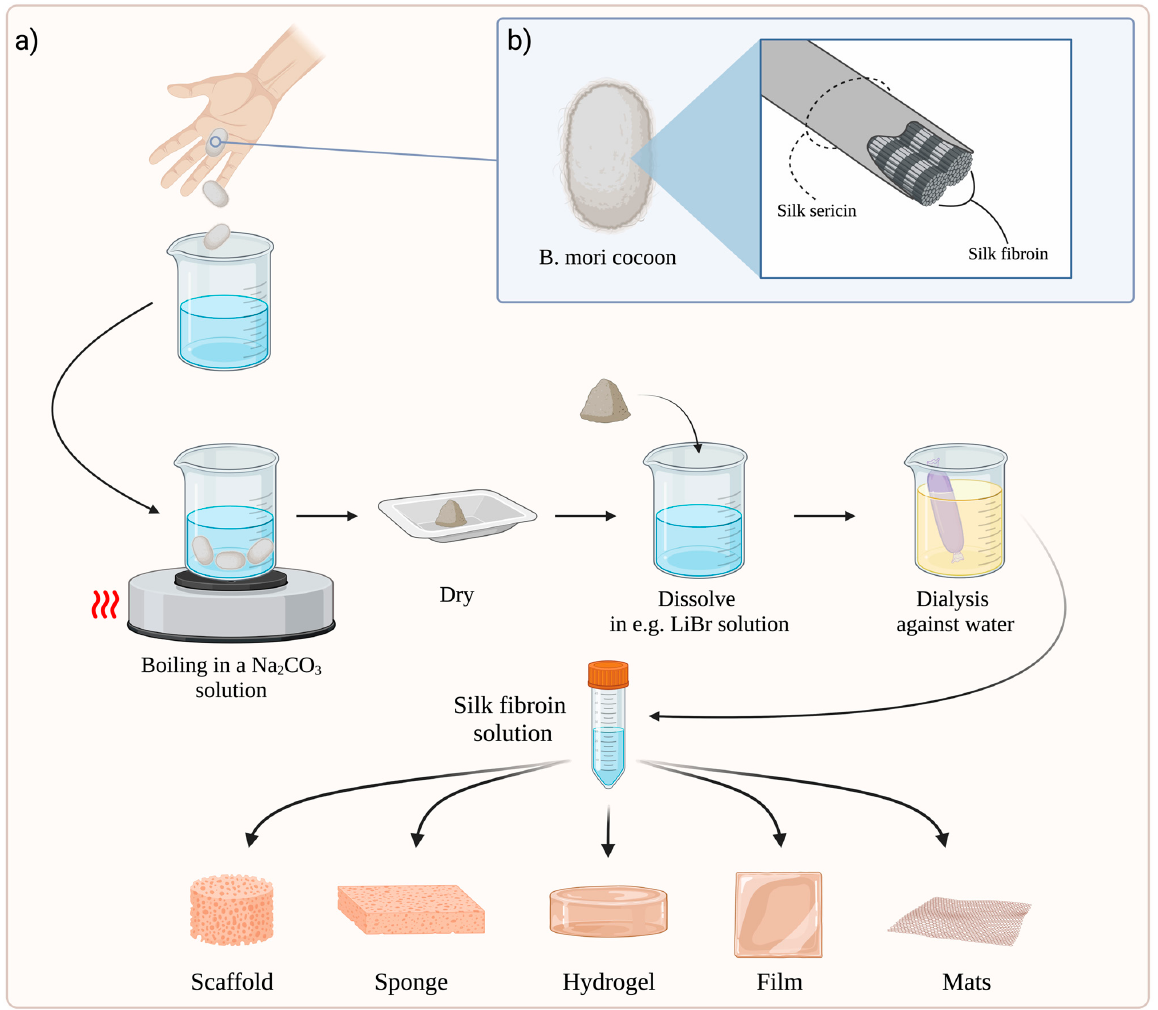
Figure 1. ( a ) General schematic process for obtaining various types of dressings based on SF. The figure was created based on Thurber et al. [69] and refs. [54–58,70]. ( b ) General scheme of silk fibre structure. Fibroin is bonded and held together by sericin [25–27]. Abbreviations: B. mori—Bombyx mori; Na 2 CO 3 —sodium carbonate; LiBr—lithium bromide. Created with BioRender.com (accessed on 10 November 2022).